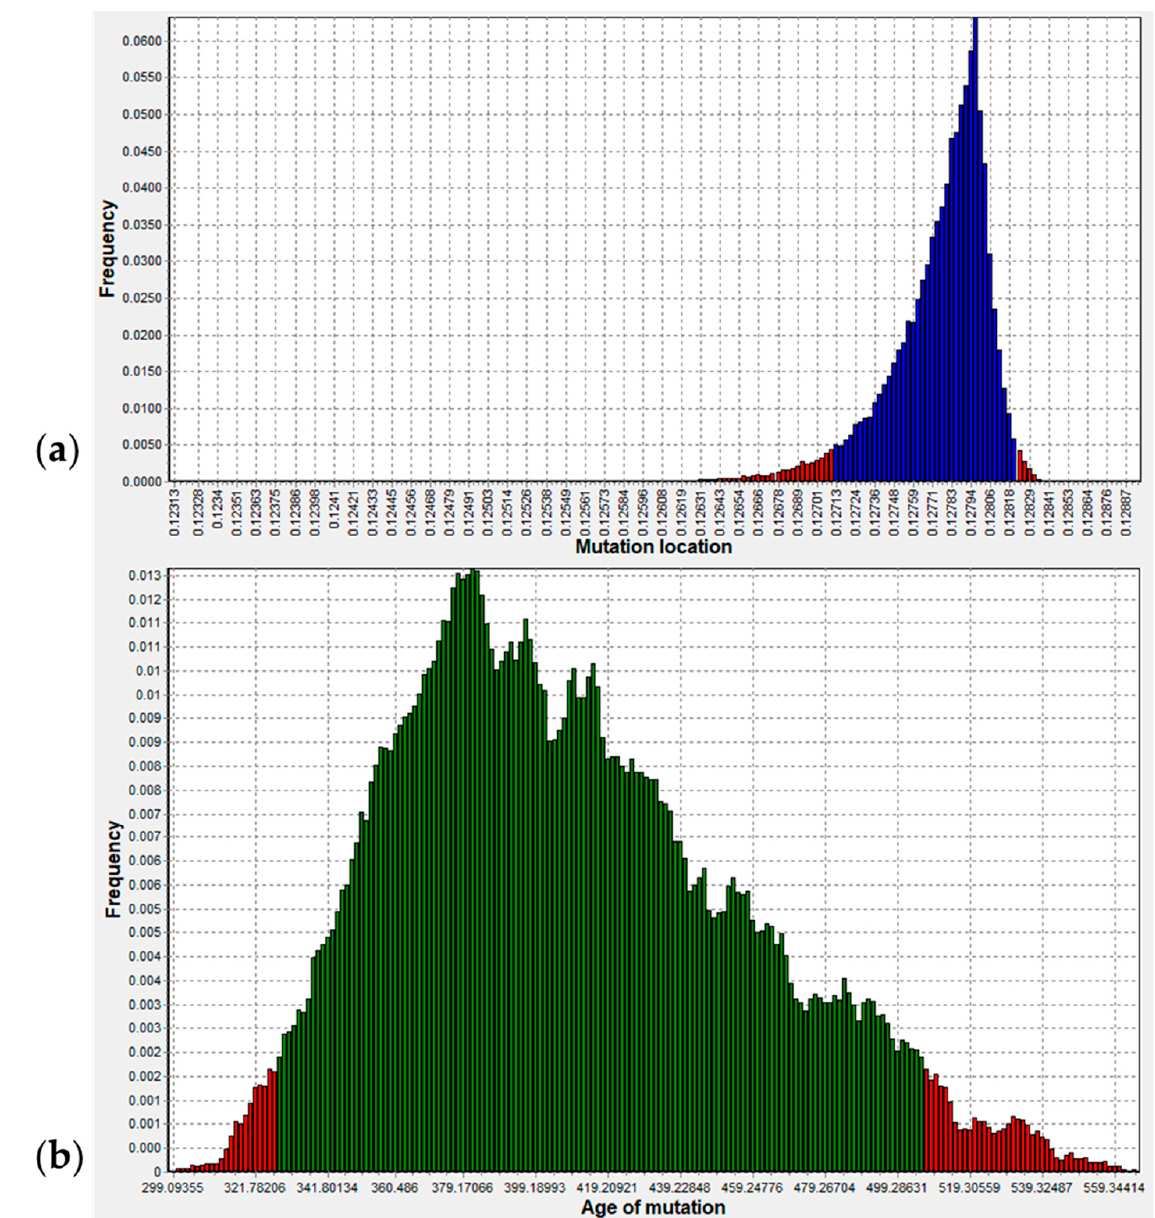
Figure 2. DMLE +2.3 estimated age of p.(Arg143Trp) (c.427C>T) in generations showing a 95% confidence interval (CI) after two chains: 2,000,000 burnin and 1,000,000 main iterations. ( a ) p.(Arg143Trp) mutation location and a 95% CI. ( b ) p.(Arg143Trp) (c.427C>T) mutation age and a 95% CI for the posterior probability density (the region in